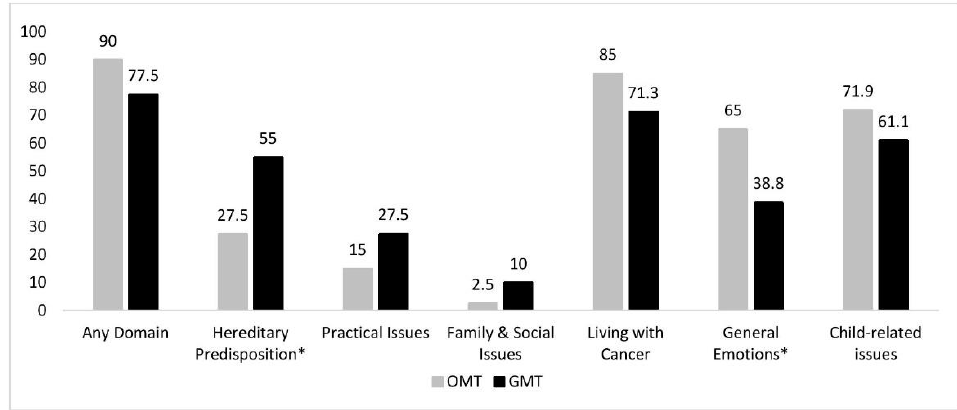
Figure 2. Proportion of individuals who screened positive on Psychosocial Aspects of Hereditary Cancer. GMT: Genetic counselor-mediated genetic testing; OMT: oncologist-mediated genetic testing. * OMT and GMT differed significantly in the proportion who screened positive on the Hereditary Predisposition ( p = 0.005) and General Emotions ( p = 0.007) domains of the PAHC tool.